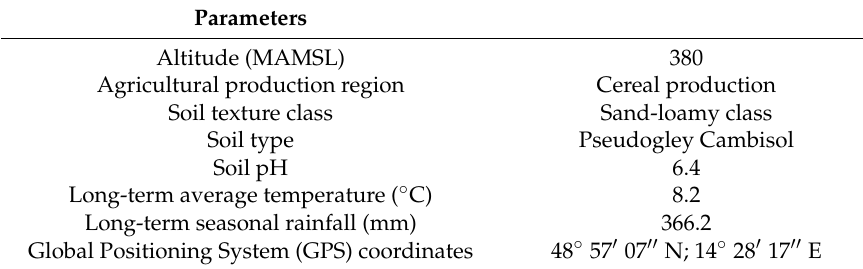
Table 2. The station characteristics (modified from [26]).